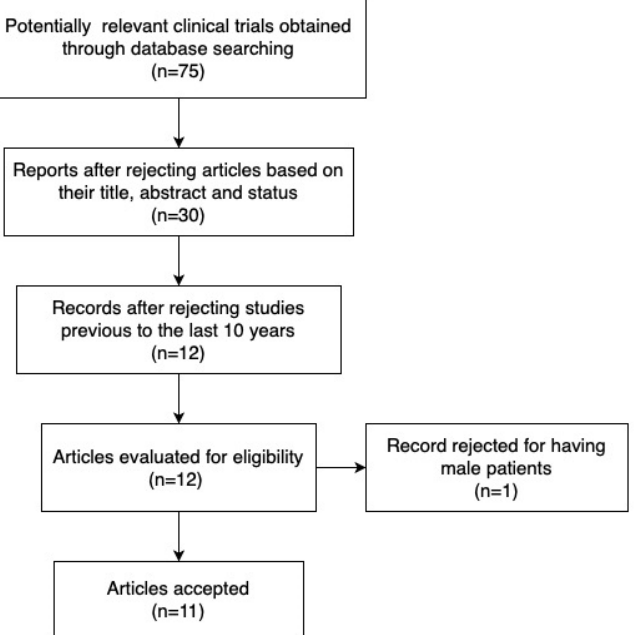
Figure 2. Flow chart demonstrating the selection method of clinical trials for this review.